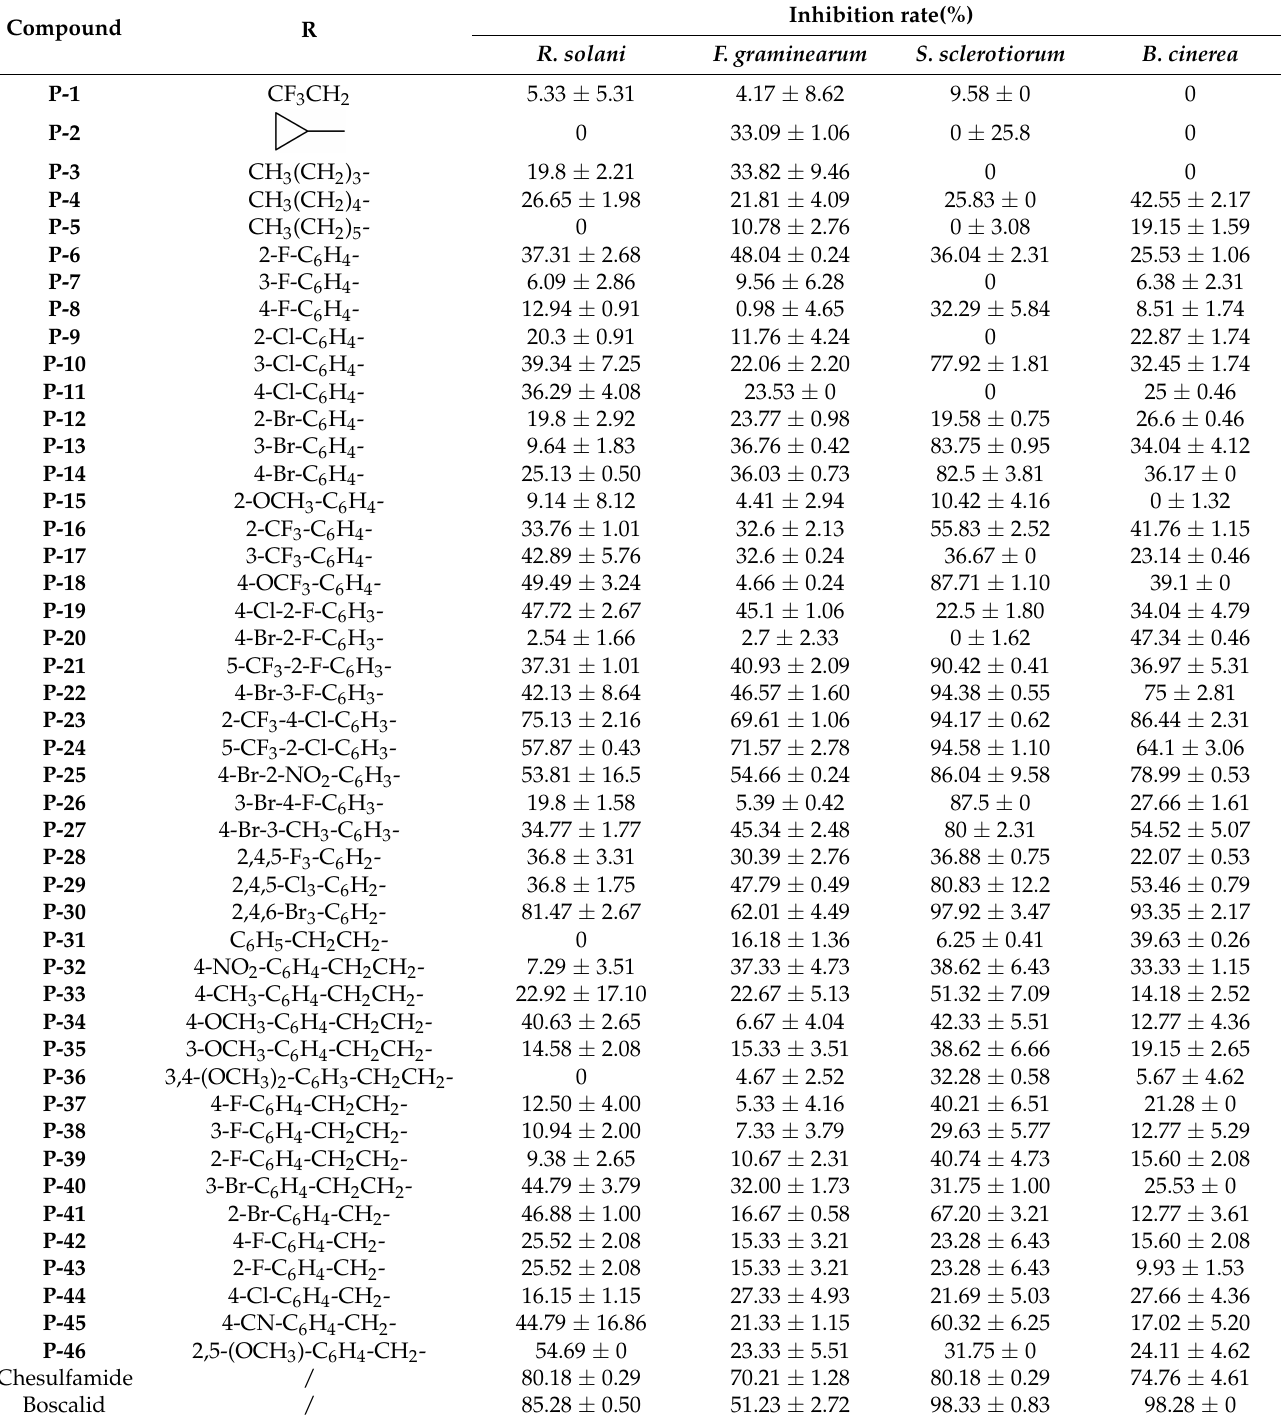
Table 1. In vitro fungicidal activity of target compounds at 50